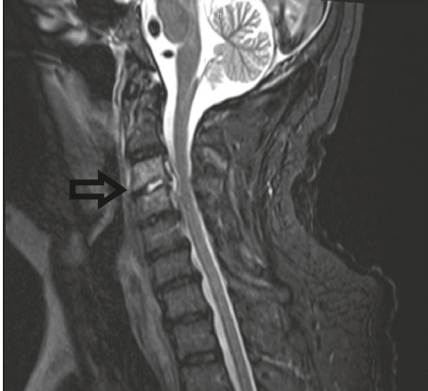
Figure 2: MRI of spine with and without contrast showing C discitis-osteomyelitis (black arrow), with associated epidural ab- scess (day 9 of